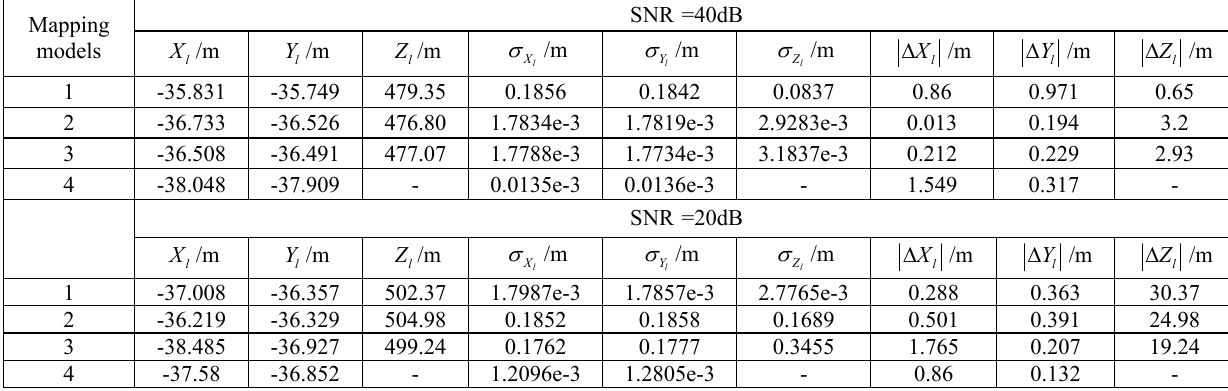
Table 1. The deduced positions from four mapping models and their location errors